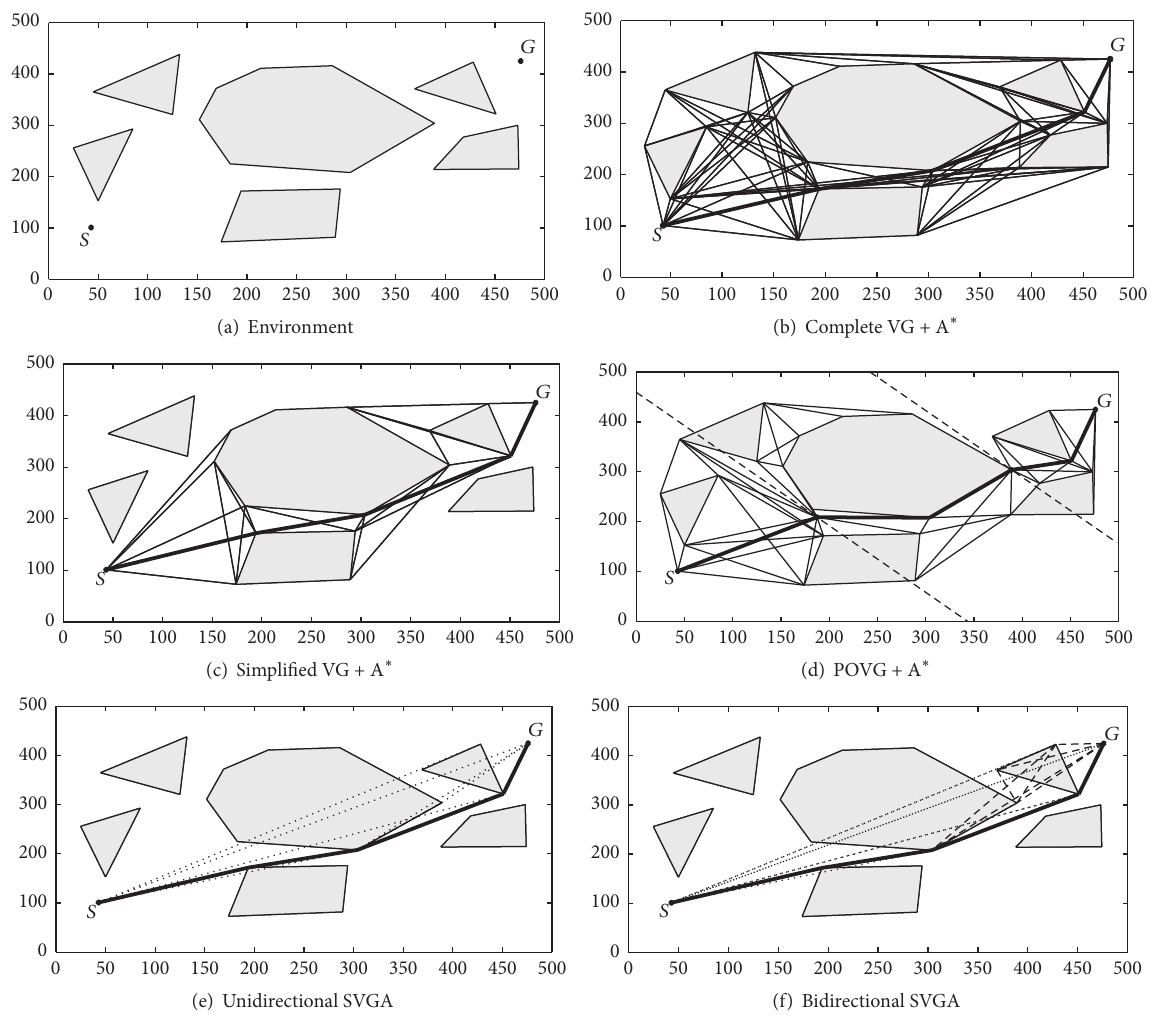
Figure 4: Comparison between five algorithms in an